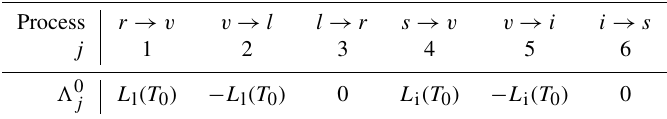
for the system of j